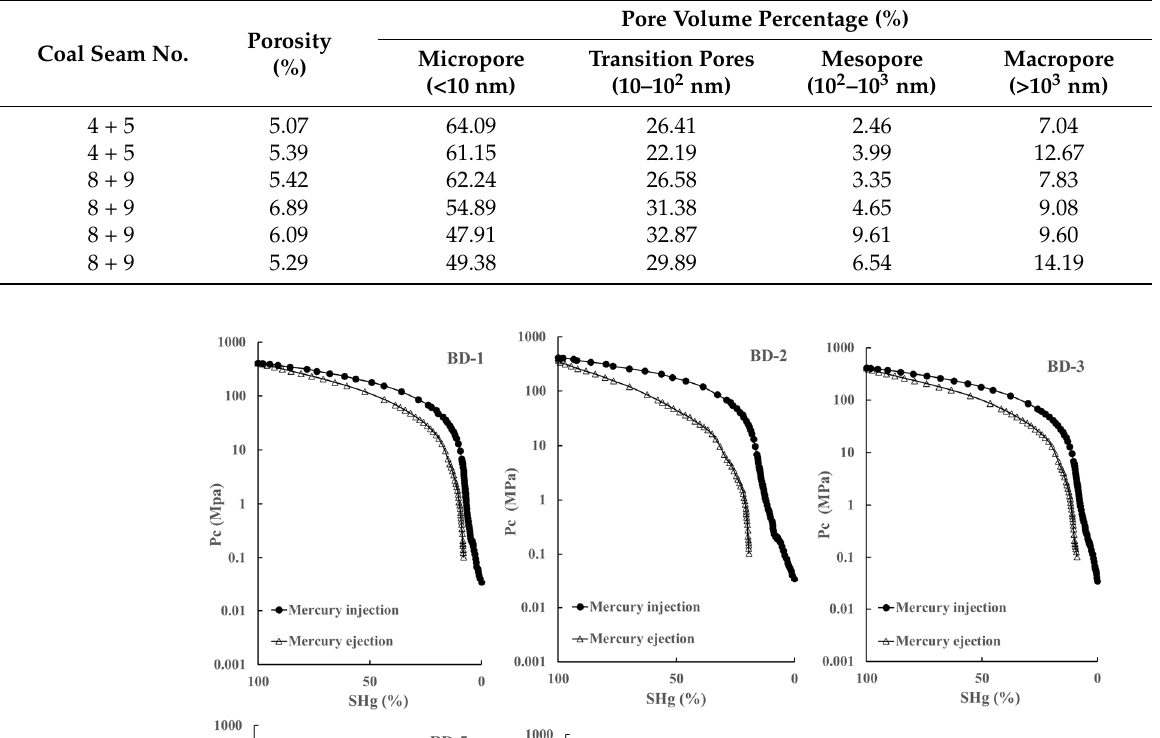
Table 4. Mercury injection data of typical samples in the Baode block.